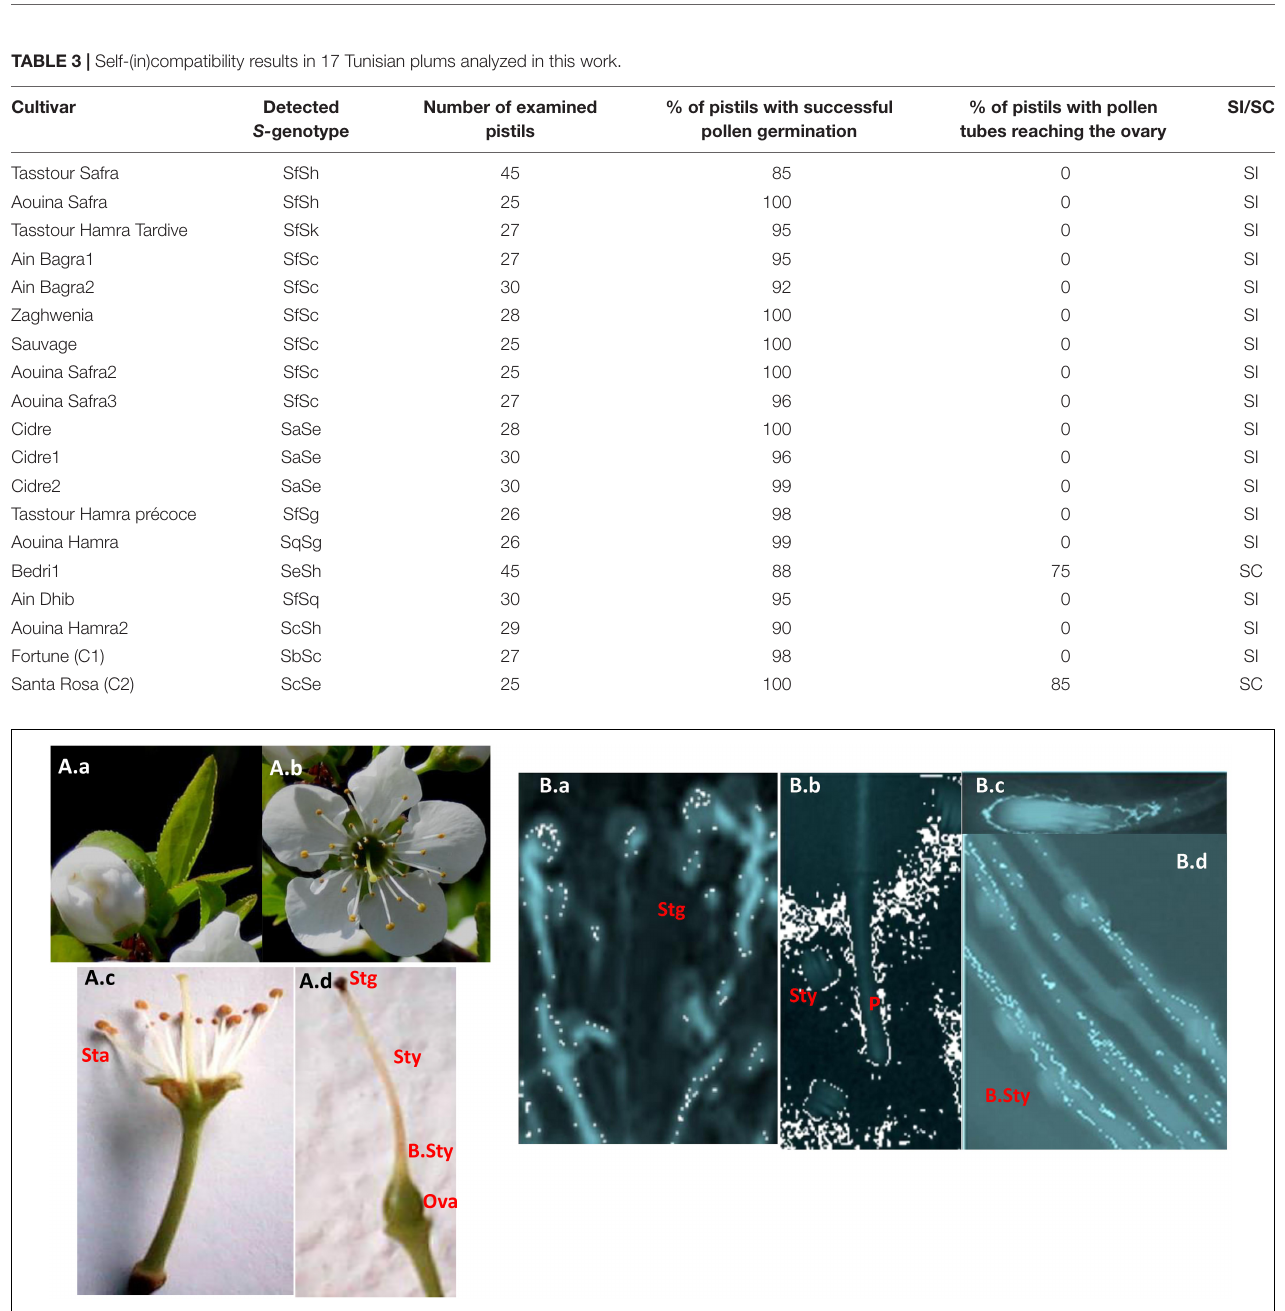
FIGURE 2 | Pollen germination and pollen tube growth in flowers of Tunisian Japanese plums. (A) Flowers. (a) Balloon stage. (b) Full bloom. (c) Reproductive organs. (d) The pistil. (B) Pollen germination. (a) Germination at the stigma surface. (b) Pollen tube arrested in the style in an incompatible reaction. (c) The pollen tube tip. (d) Pollen tube growing in the base of the style in a compatible reaction. Scale bars = 50 µ m. Sta, stamens; Stg, stigma; Sty, style; B.Sty, the base of the style; Ova, ovary; P, Pollen